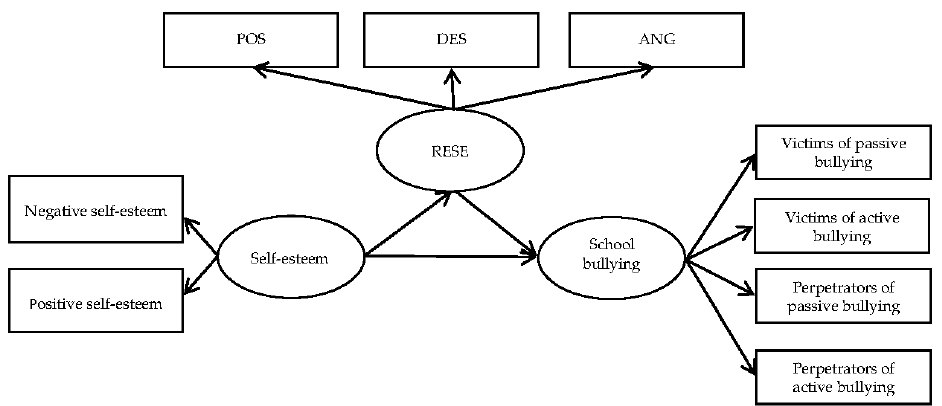
Figure 1. Structural model of regulatory emotional self-efficacy (RESE) as a mediator of self-esteem and school bullying. All three variables (school bullying experience, self-esteem and RESE) are latent variables measured by a few indicators. POS = the perceived capability of expressing positive affect, DES = the perceived capability of managing despondency-distress, ANG = the perceived capability of managing anger-irritation.